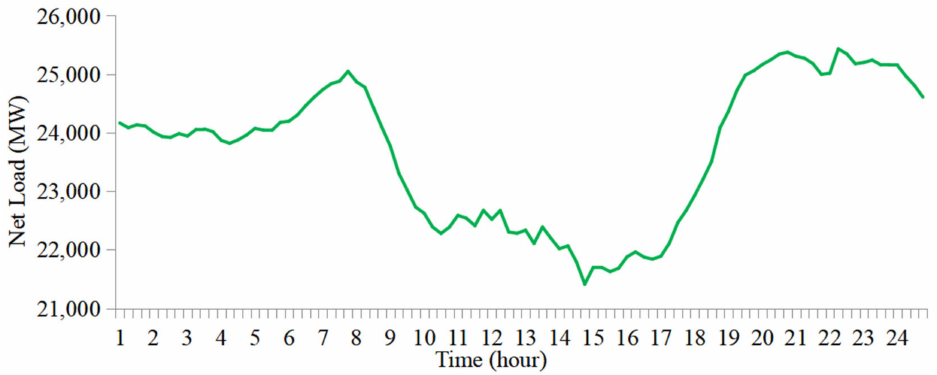
Figure 8. Net load curve of the provincial power